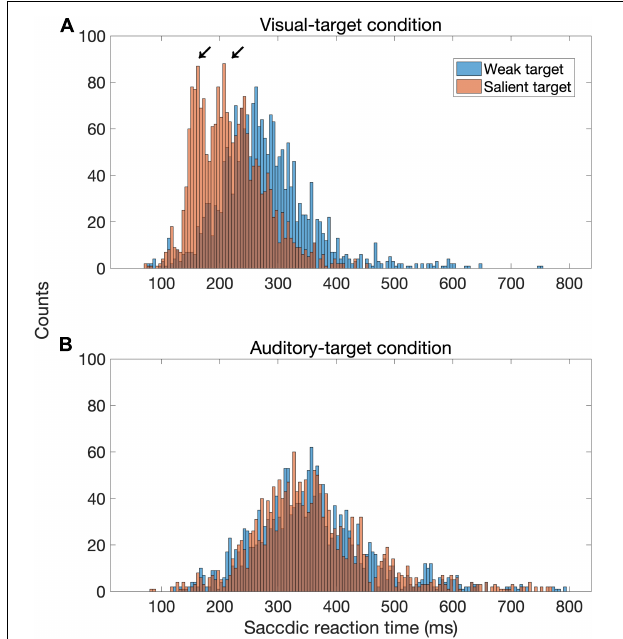
FIGURE 9 | Distribution of saccadic reaction time (SRT) for the visual-target condition (A) and the auditory-target condition (B) . In this figure, factors other than target saliency were combined. The distribution seems to be bimodal when the visual target was strong (red bars) compared to when it was weak (blue bars), whereas there is no such a tendency for the auditory-target